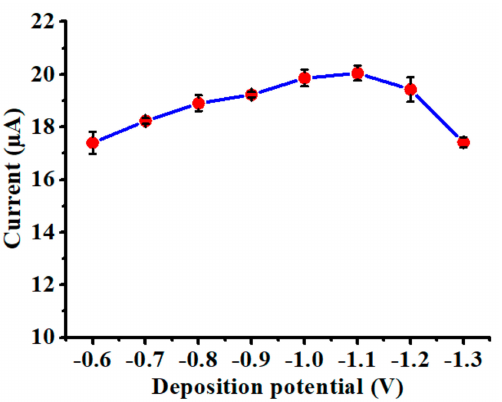
Figure 5. Influence of deposition potential on the stripping peak current of the nanoparticles-modified chemical sensor in the solution of 20 µ g/L Cd(II) with 0.1 M acetate buffer, where deposition time is 60 s. Data are presented as the mean of three replicates and error bars denote the standard deviations.